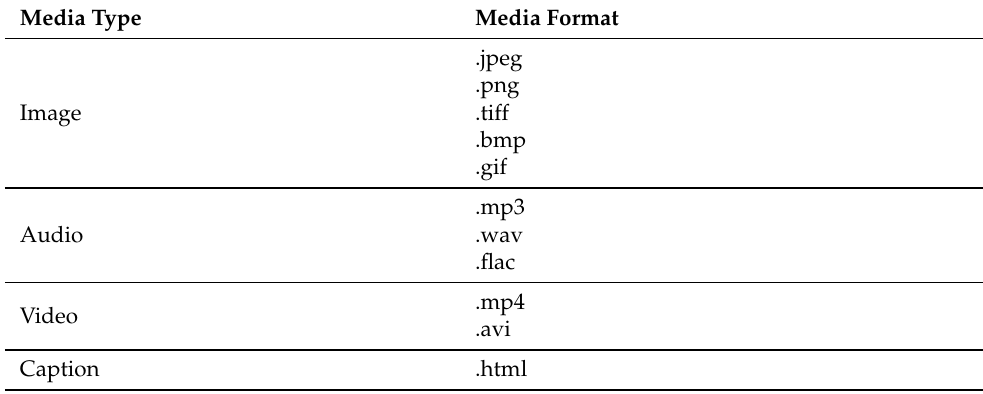
Table 1. Embedded Objects’ Media types supported by JPEG Snack